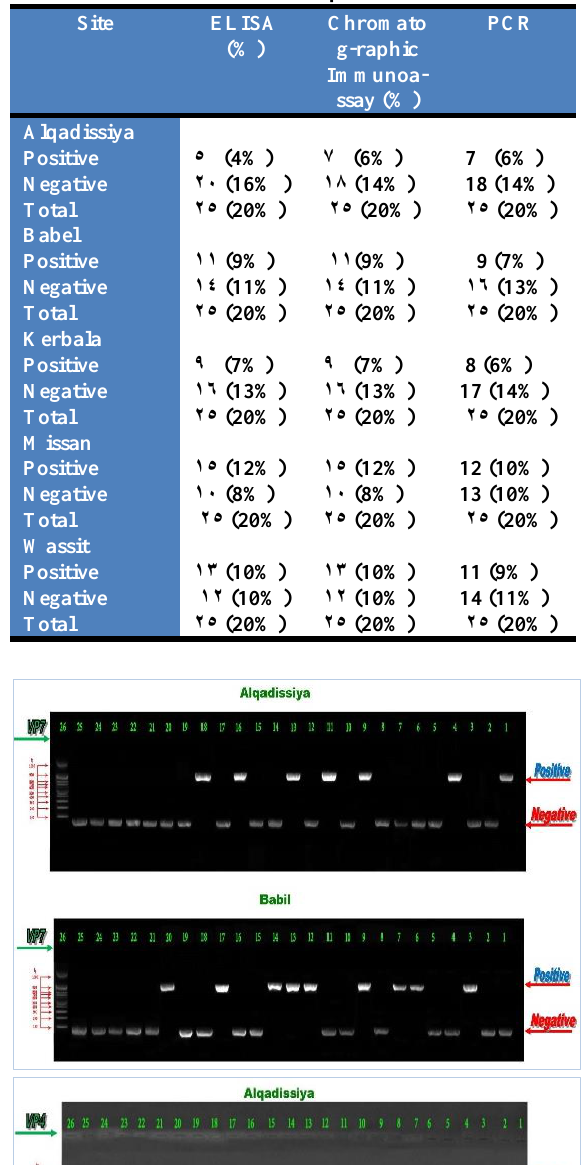
Table, 1: The percentage for three testing methods for Rotavirus in 125 fecal samples.